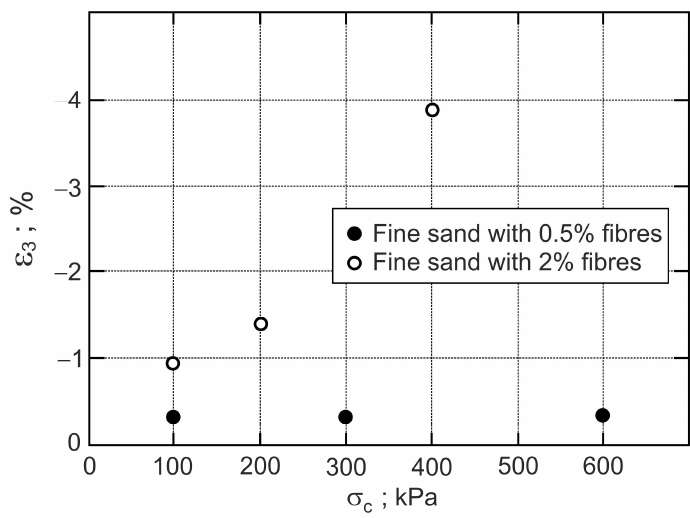
Figure 8. Principal tensile strain at threshold states.